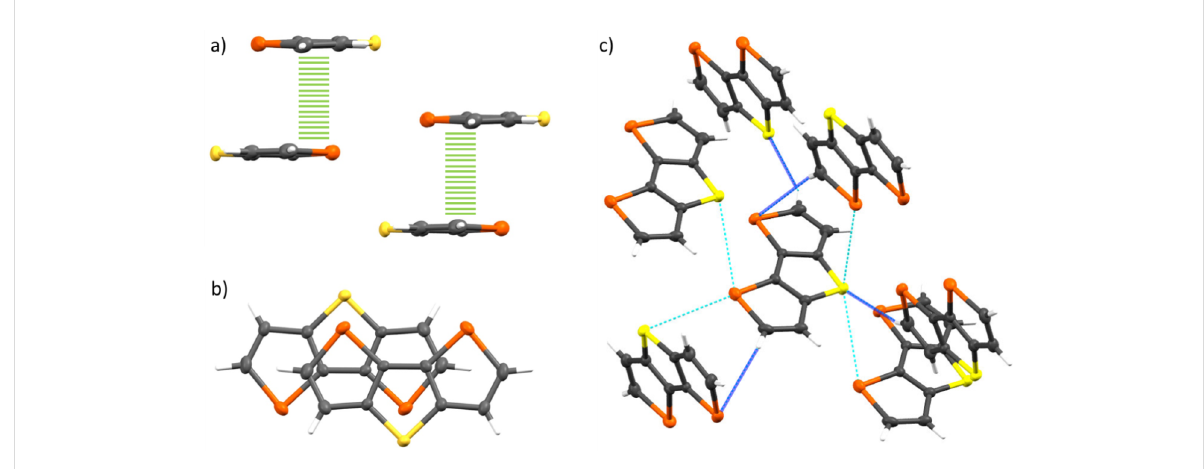
Figure 3: Single crystal X-ray structure analysis of selenolotriacene DST 3 : (a) partial overlap of stacked and displaced molecules leading to π – π interactions with distances down to 3.42 Å (side view); (b) and top view (64% molecular overlap). (c) Intermolecular interactions between heteroatoms and hydrogen-heteroatoms (labelled cyan and blue,